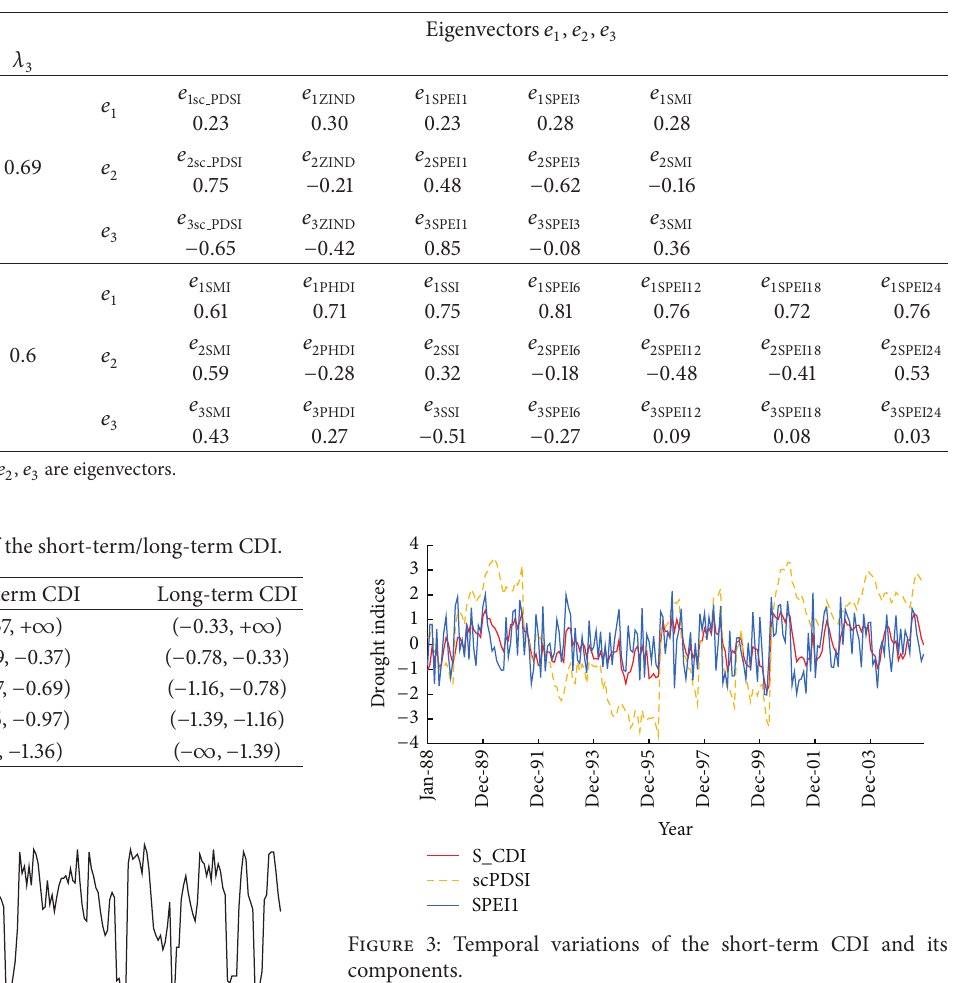
Table 3: Eigenvalues and eigenvectors of the PCA for short-term/long-term CDI in the upper Huaihe River basin.